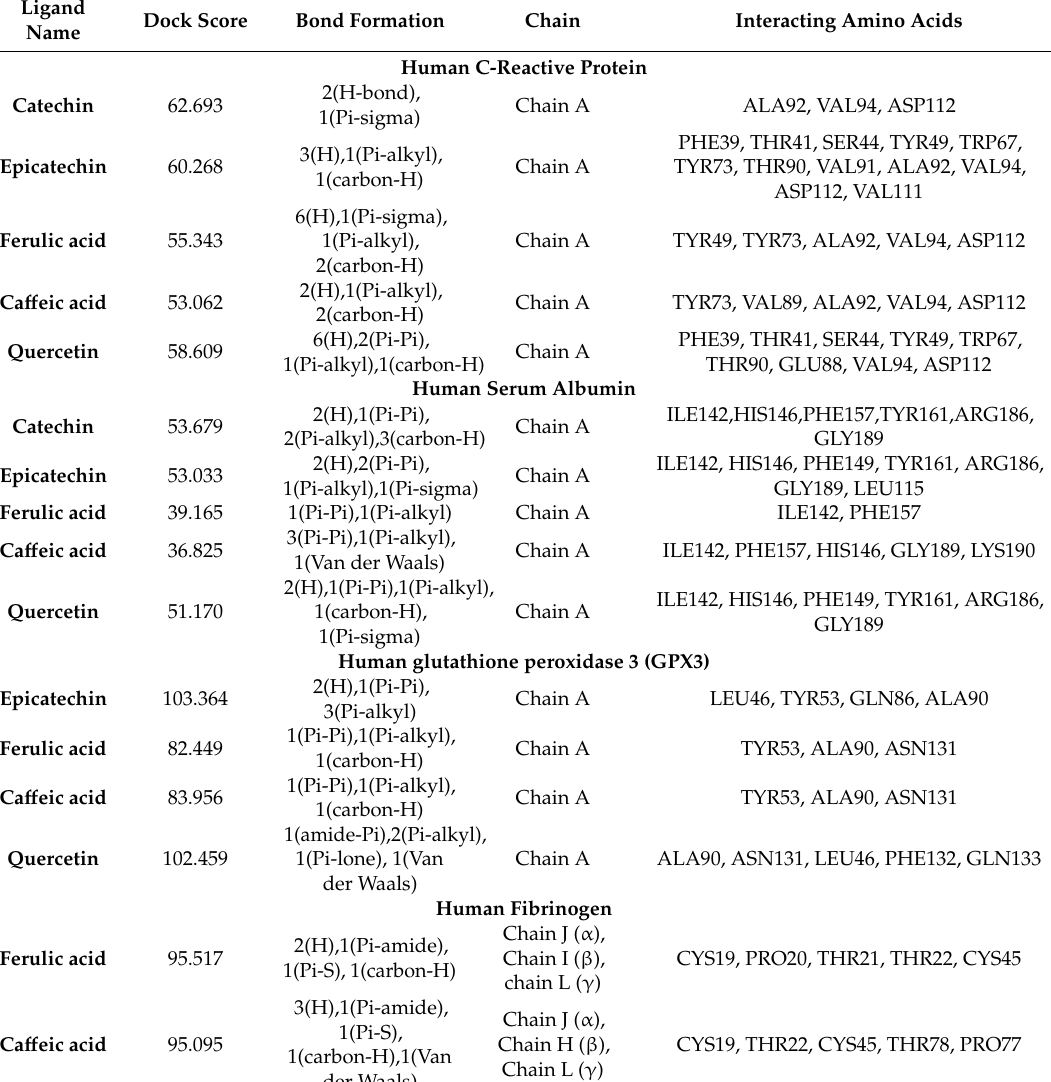
Table 4. Molecular docking results are indicated with dock score for the flavonoids and phenolic acids against di ff erent serum